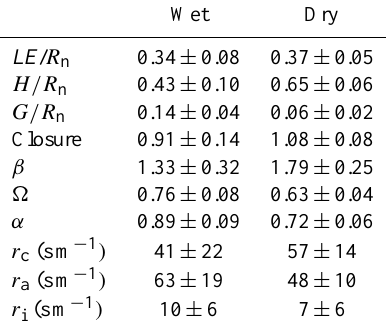
Table 4. Mean midday energy partitioning and bulk parameters at the BE site between 20 July and 12 August during wet, but not inundated (2006 and 2008), and dry (2007) soil moisture conditions. Only days with VPD below 0.3kPa are included. Dry soil moisture conditions represent 9 < − 0.13MPa at 10cm depth, which equals a water table at ∼ 15cm depth, and no prior precipitation.